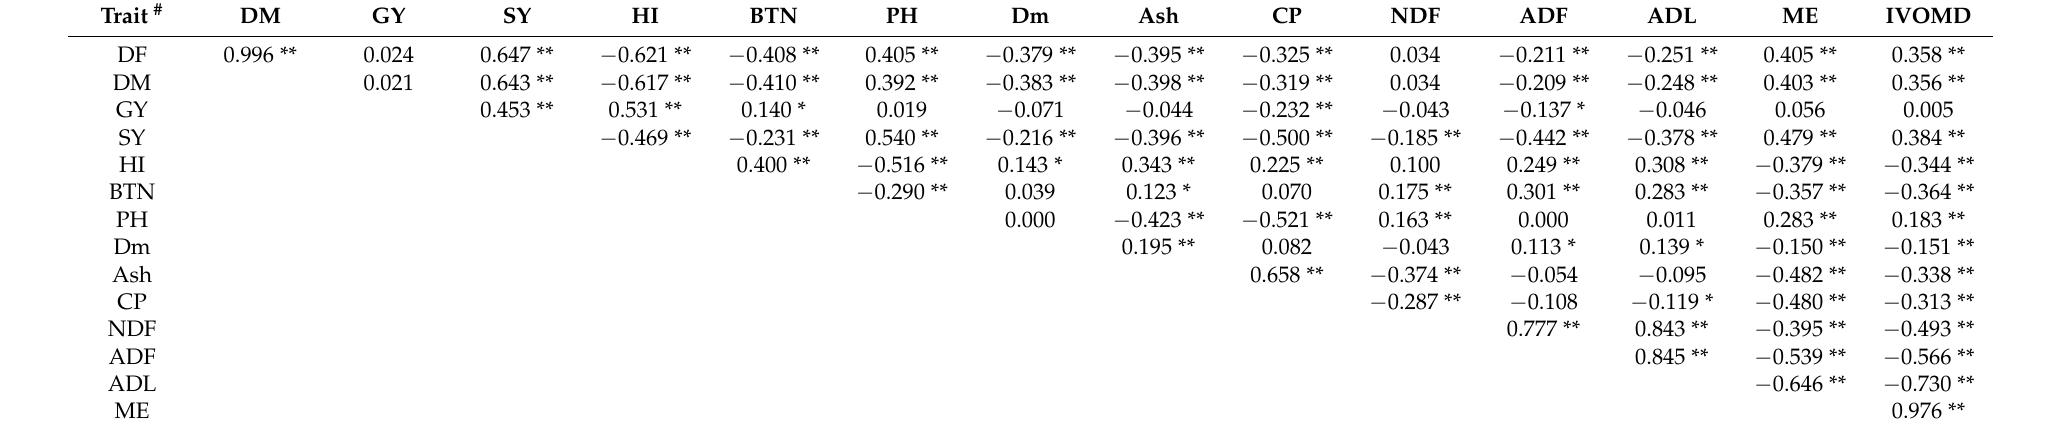
Table 4. Correlation among forage quality and agronomic traits in 314 finger millet